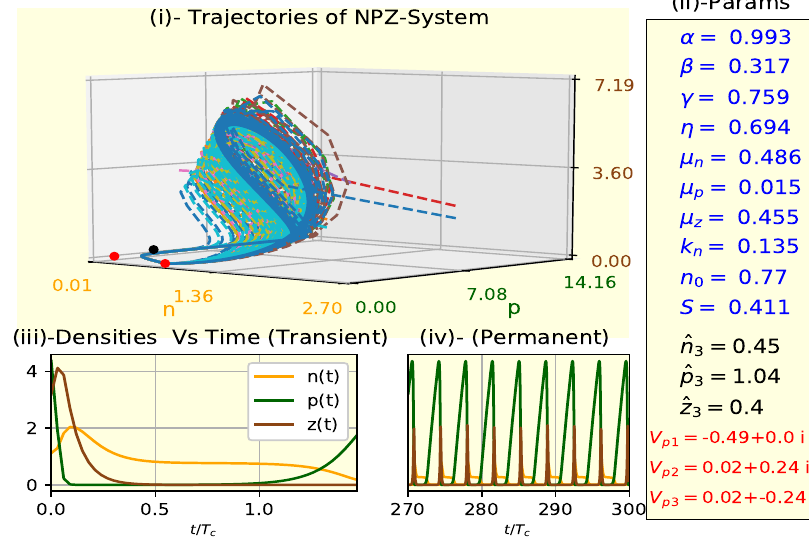
3 and in red the two others .(ii)-System